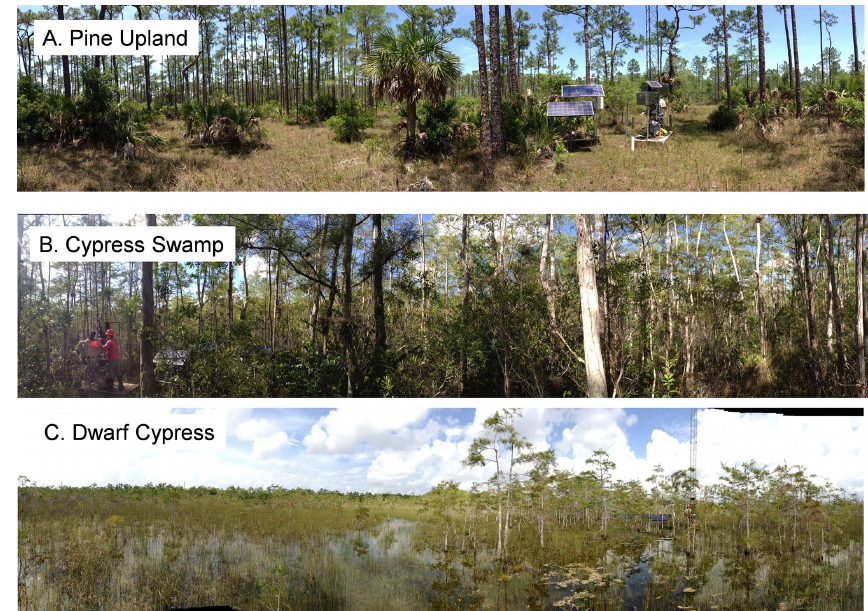
Figure 2. Panoramic photos of the (a) Pine Upland, (b) Cypress Swamp and (c) Dwarf Cypress plant communities.